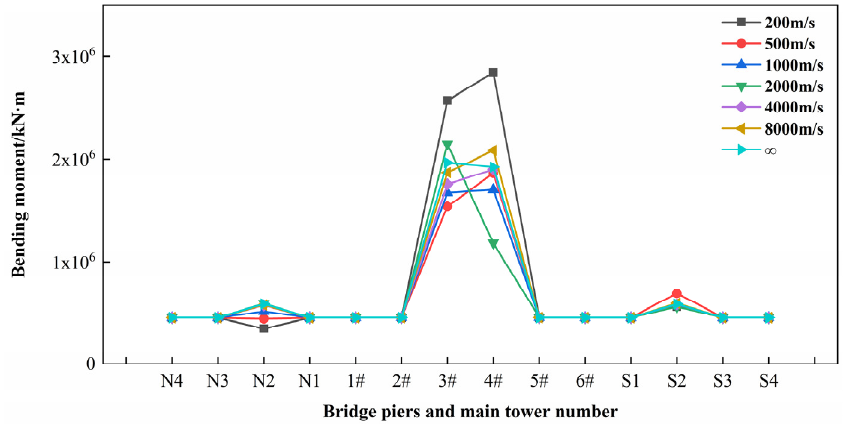
Figure 23. The absolute maximum value of the bending moment at different apparent wave velocities. Table 10. Absolute maximum of internal force at the bottom of 3# main tower at different visual wave speeds.